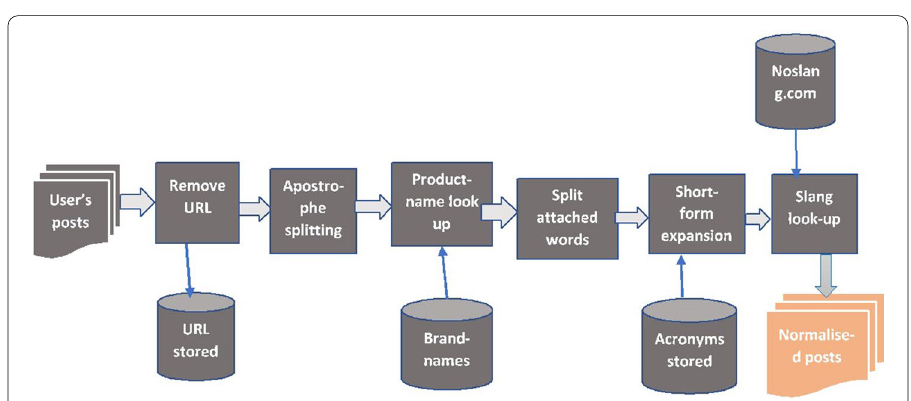
Fig. 1 Framework for Normalizing and